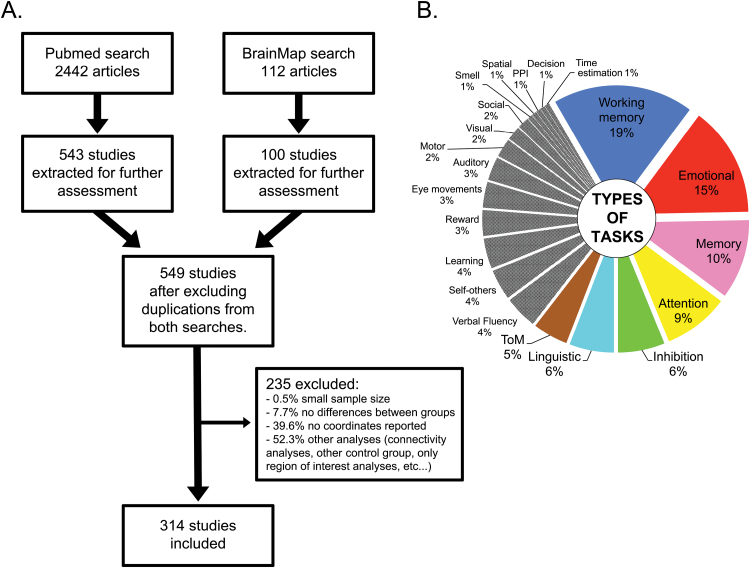
Literature search and studies included. (A) Flow-chart of literature search. (B) Characteristics of paradigms in included studies. In color, tasks that were present in more than 5% of publications. These were balanced in the domain-general analysis.